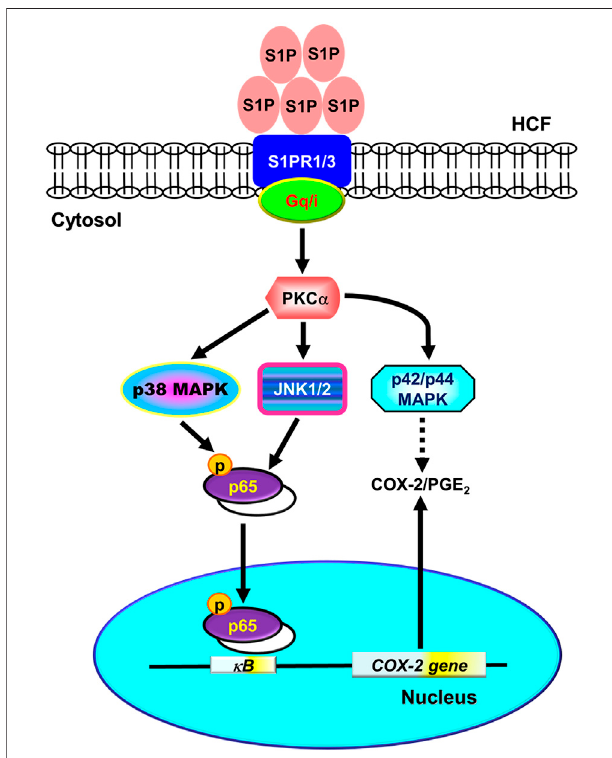
FIGURE10| Schematicrepresentationofsignalingpathwaysinvolvedin S1P-induced COX-2/PGE 2 expression in HCFs. Binding of S1P to G q - or PTX-sensitive G i protein-coupled S1PR1/3 results in PKC α -dependent phosphorylationofMAPKs(i.e.,p42/p44MAPK,p38MAPK,andJNK1/ 2) leading to activation of NF- κ B. The COX-2 transcription is dependently regulated by MAPK-mediated NF- κ B cascades. These signaling pathways contribute to d activation of NF- κ B required for COX-2 expression and PGE 2 generation in HCFs.